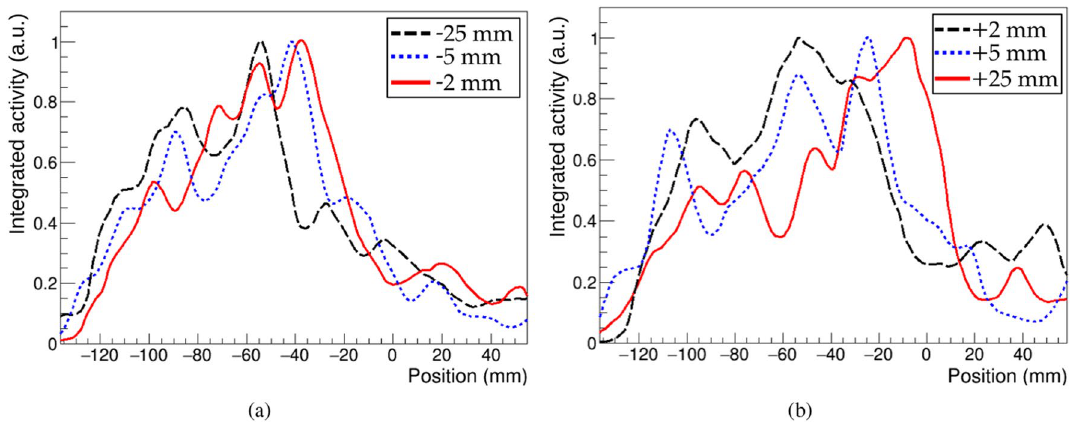
Figure 4. Line profiles along the beam direction from images at 4.4 MeV shown in Fig. 3: ( a ) top row, ( b ) bottom row.